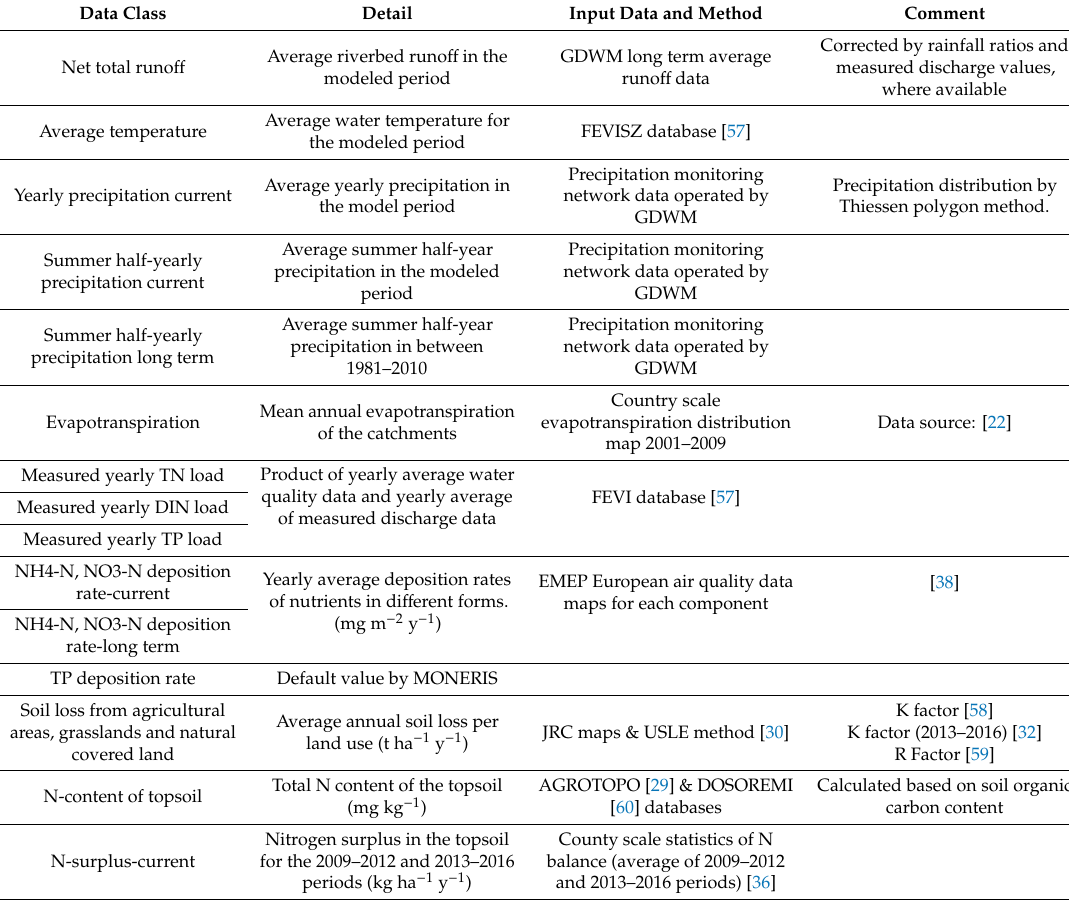
Table A2. Temporal data used for the MONERIS